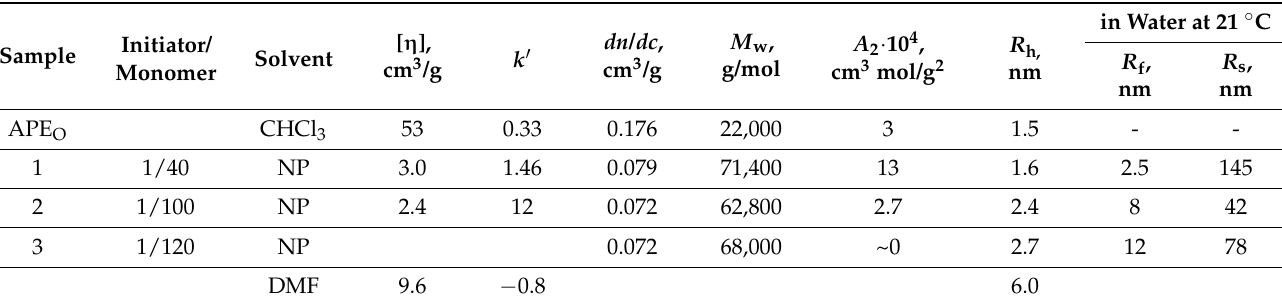
Figure 4. Concentration dependences of cH/I ex ( a ), R h ( b ), and η sp / c ( c ) for APE O solutions in CHCl 3 . Table 1. Molecular characteristics for APE O and APE O -g-PiPrOx.